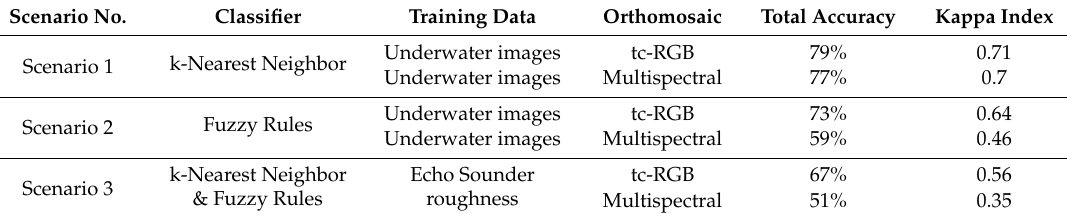
Table 10. Brief table of total accuracies for the tc-RGB and multispectral orthomosaics of the three scenarios of the